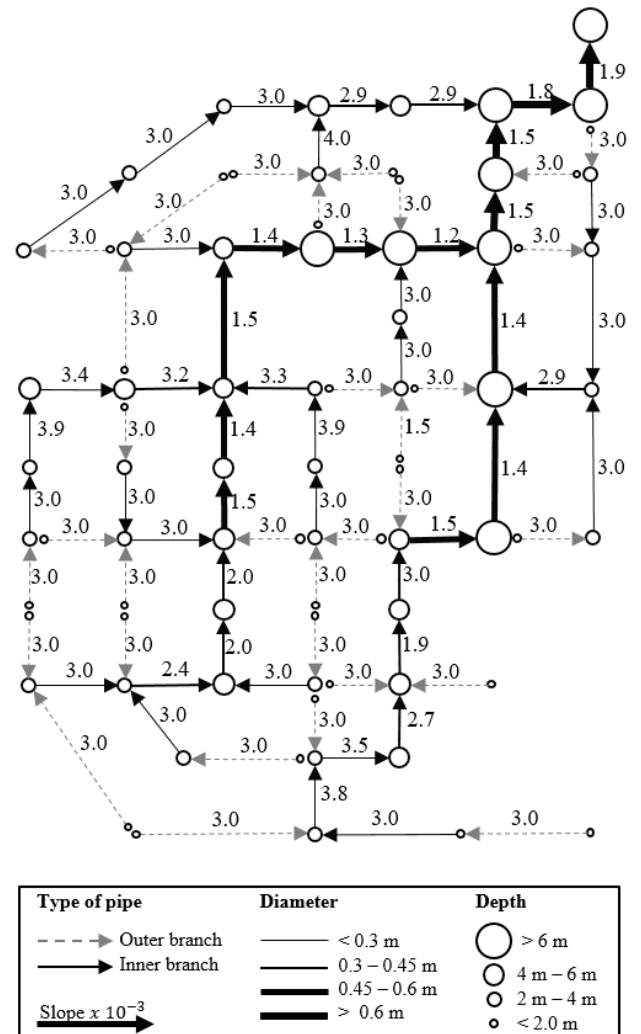
Figure 6. Layout and hydraulic design ( ∆ Z = 0.01 m) of the benchmark proposed by Li and Matthew [34], using the proposed methodology. Table 2. Comparison of the construction cost for the benchmark proposed by Li and Matthew